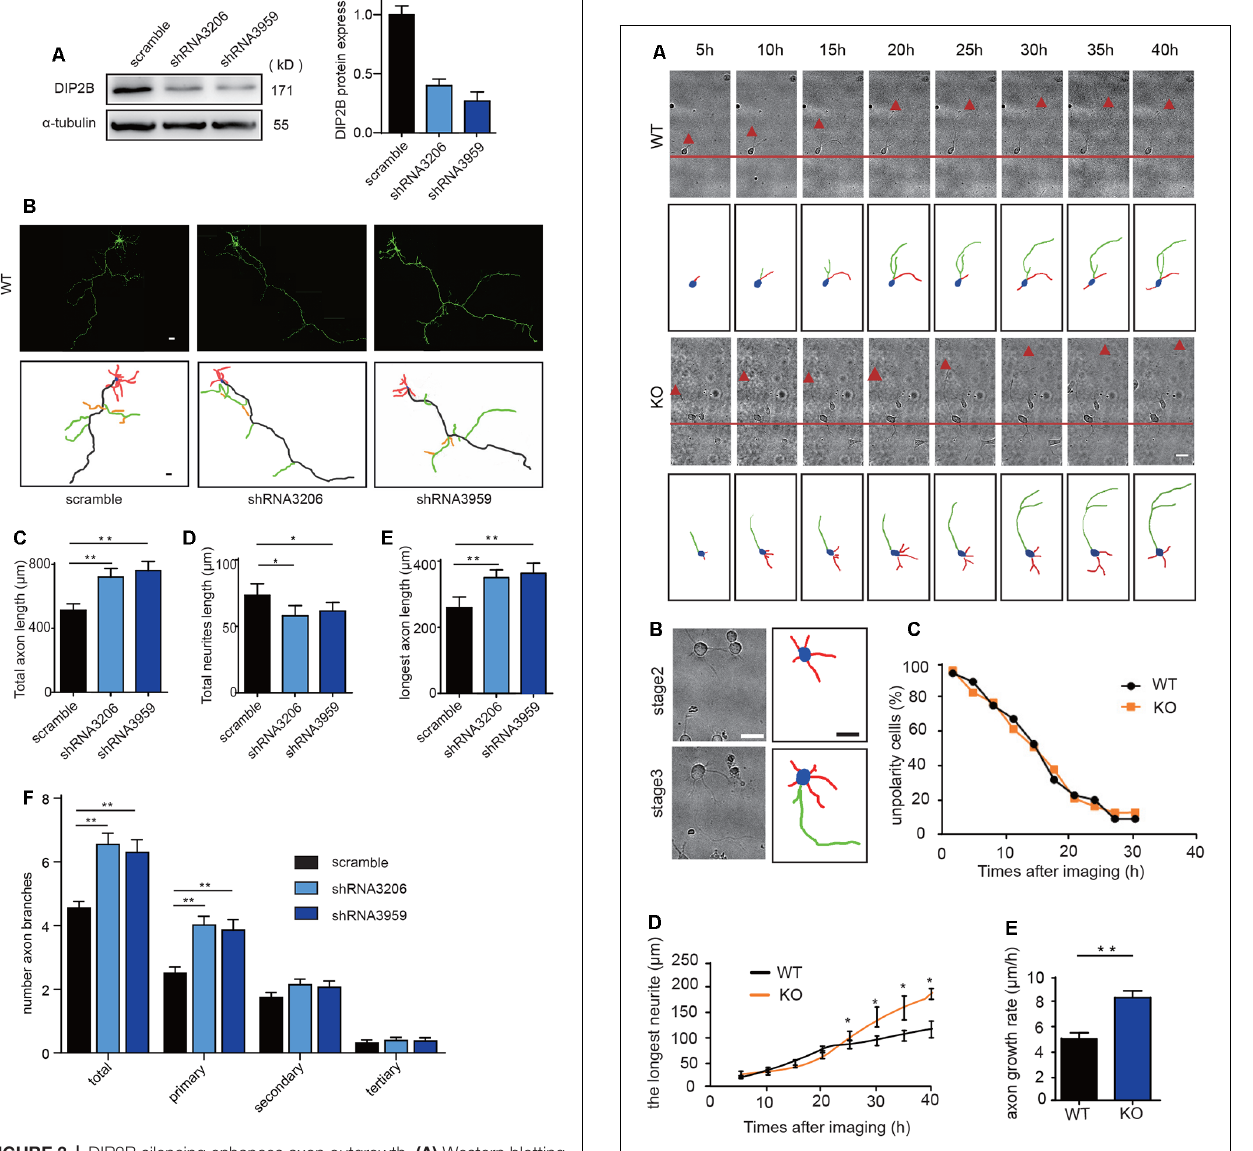
FIGURE 4 | DIP2B is critical for axon outgrowth following polarity formation. (A) Representative images of axonal development during the first 40 h of plating. WT: littermate controls of DIP2B knockout mice; KO: DIP2B knockout mice. Scale bar: 20 µ m. (B) Representative images of stage 2 and 3 axonal development. Scale bar: 40 µ m. (C) The average percentage of unpolarized to total neurons. (D) Average traces of neurite outgrowth from 20 to 40 h post-plating (WT, n = 83; KO, n = 82). (E) Average axonal growth rates from panel (D) . An unpaired t- test was used for comparisons. * p < 0.05; ** p < 0.01; n, cell number. Error bars represent SEM. For further details, see Supplementary Table S1